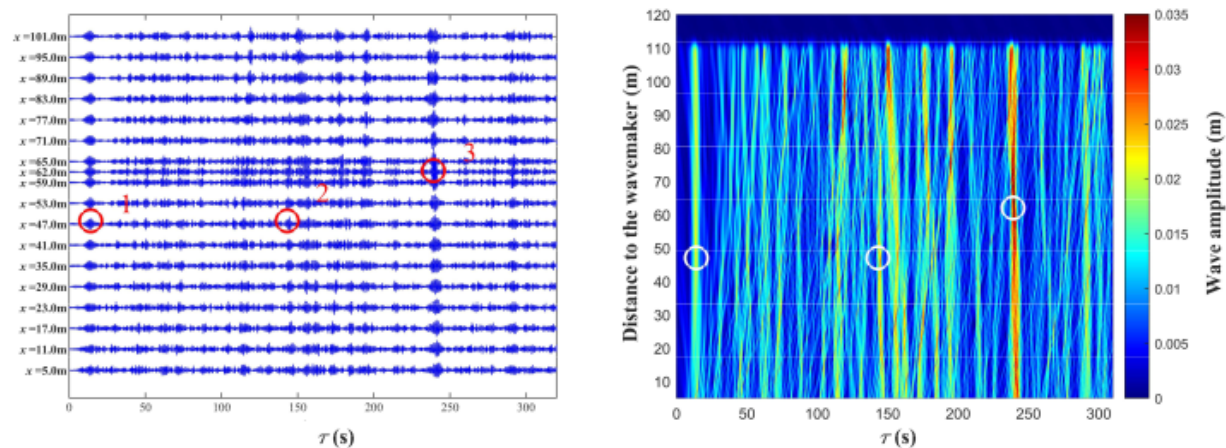
Figure 4. Left : Temporal evolution of the surface elevations at different locations (Case B: γ = 7.0, H s = 0.03 m). Right : Spatiotem- poral diagram of the wave envelope amplitude (Case B: γ = 7.0, H s = 0.03